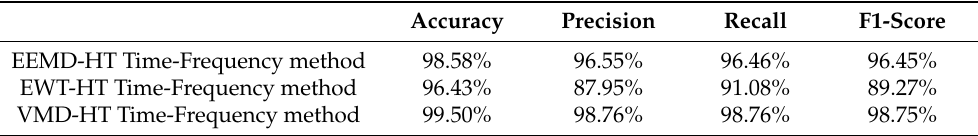
Figure 9. Evaluation indicators for classification effect of features generated by different time-frequency methods. ( a ) Accuracy for all classes. ( b ) Precision for all classes. ( c ) Recall for all classes. ( d ) F1-Score for all classes. Table 3. The improvement of proposed VMD-HT method on each class and each evaluation indi- cator compared with EEMD-HT and EWT-HT time-frequency methods.